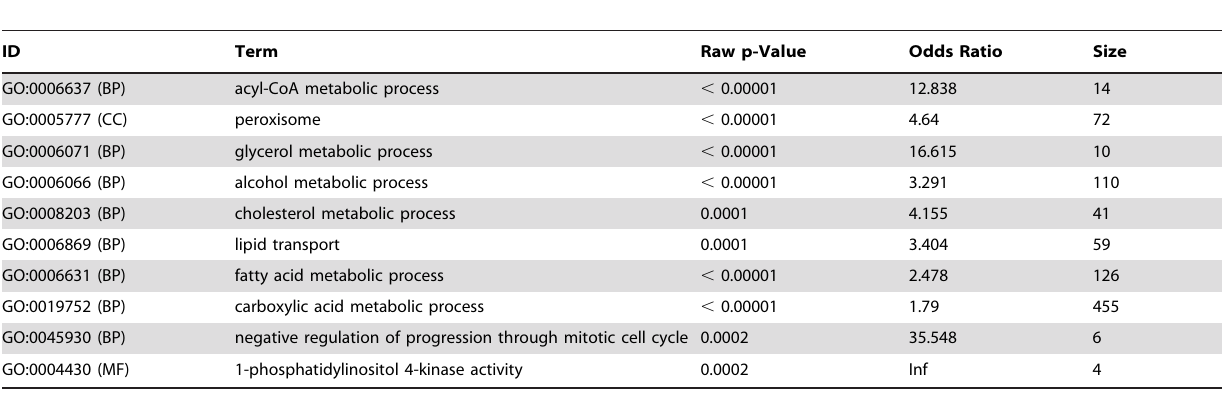
Table 1. GO enrichment analyses for the 15 mg/kg